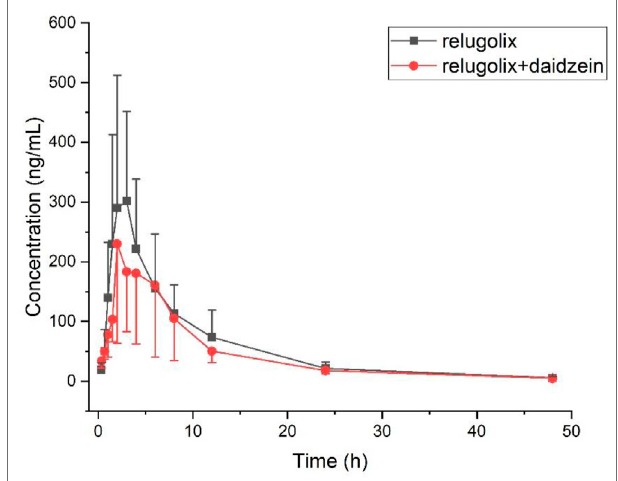
FIGURE3| Plasmaconcentrationversustimeafteroraladministrationof 12 mg/kg relugolix with or without daidzein in six rats for each group (Mean ±